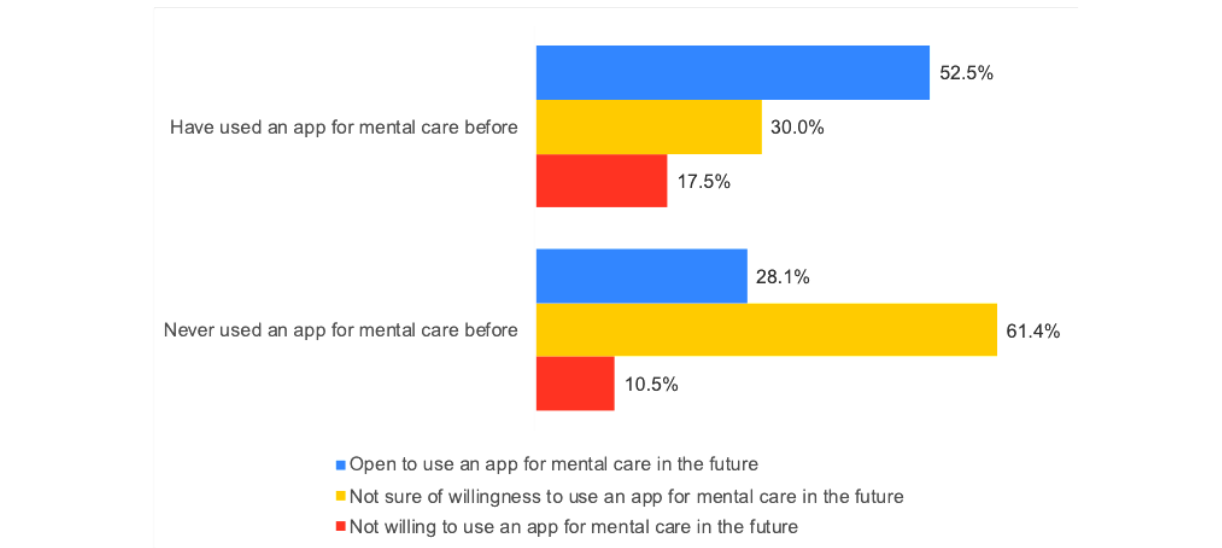
Figure 5. Associations between the answers to Q2 and